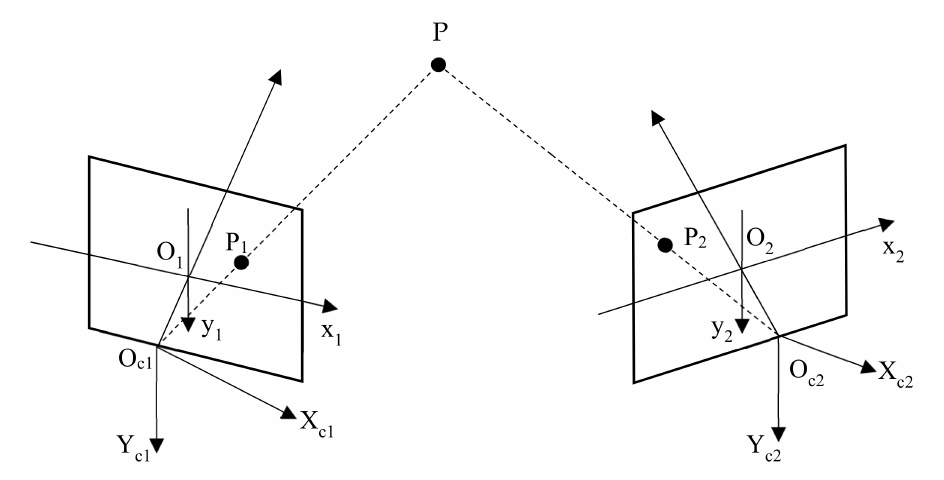
Figure 9. The coordinate calibration principle of binocular stereo